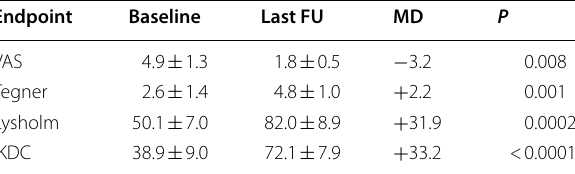
FU follow-up, MD mean difference